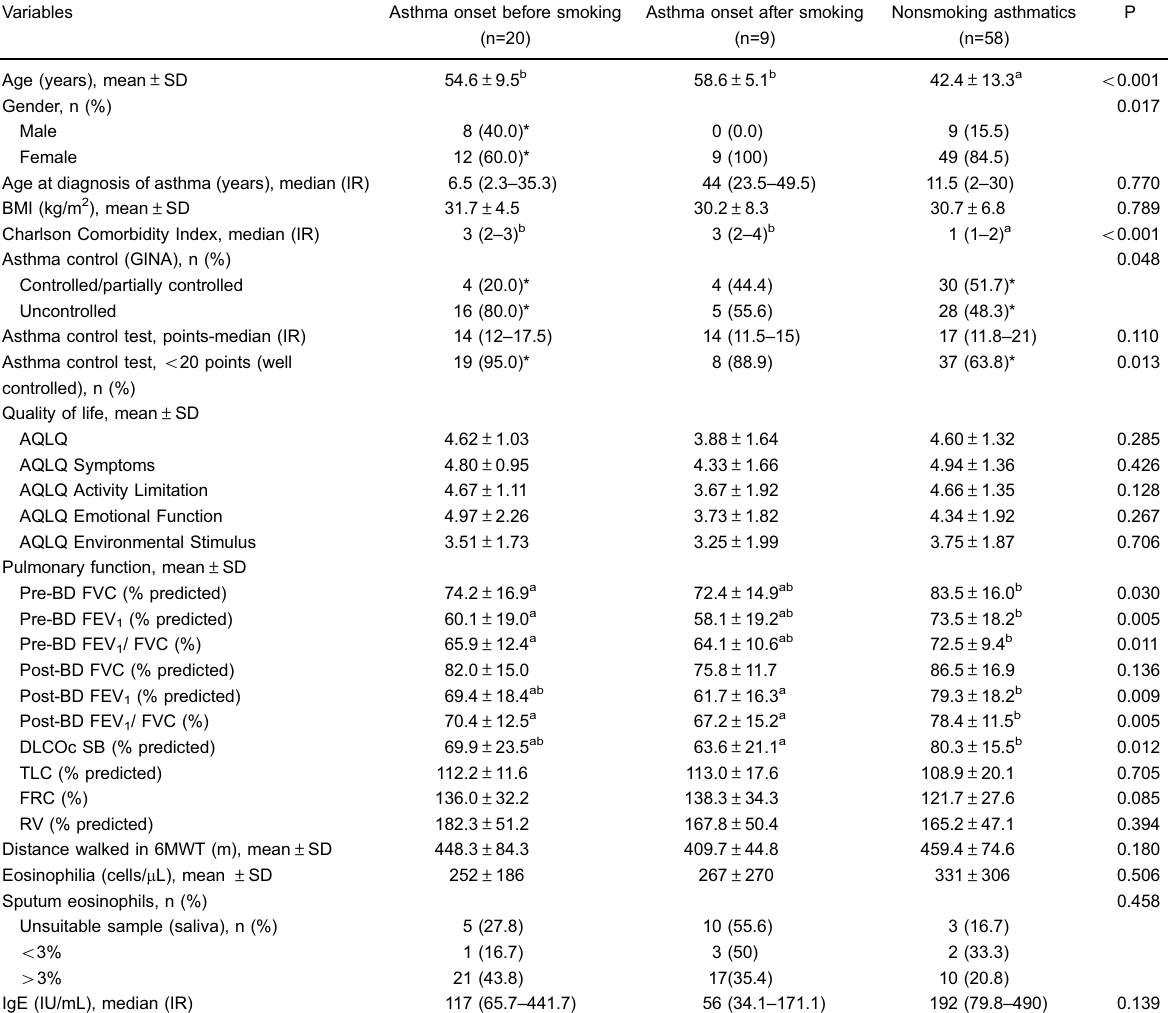
Table 4. Characteristics of patients according to the onset of asthma: asthma developed before starting cigarette smoking versus asthma developed after initiating cigarette smoking.